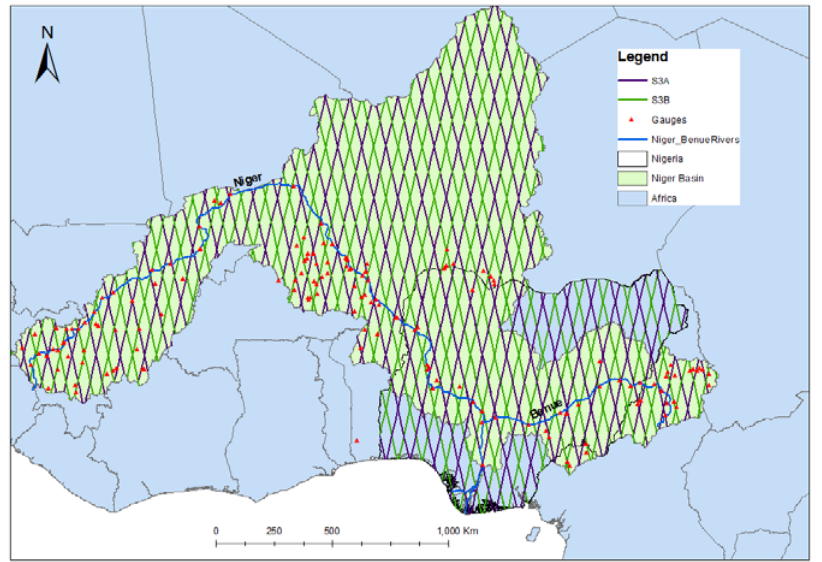
Figure 13. Sentinel 3A/B Altimetry Tracks within the Niger River Basin of West Africa.